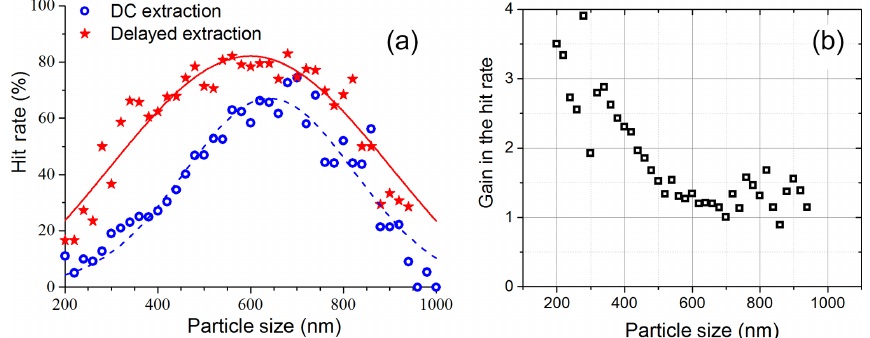
Figure 7. (a) Particles size distribution of real aerosol particles. Blue circles – DC extraction; red asterisks – delayed extraction. (b) The hit rate gain achieved by delayed extraction (DE) plotted over the particles